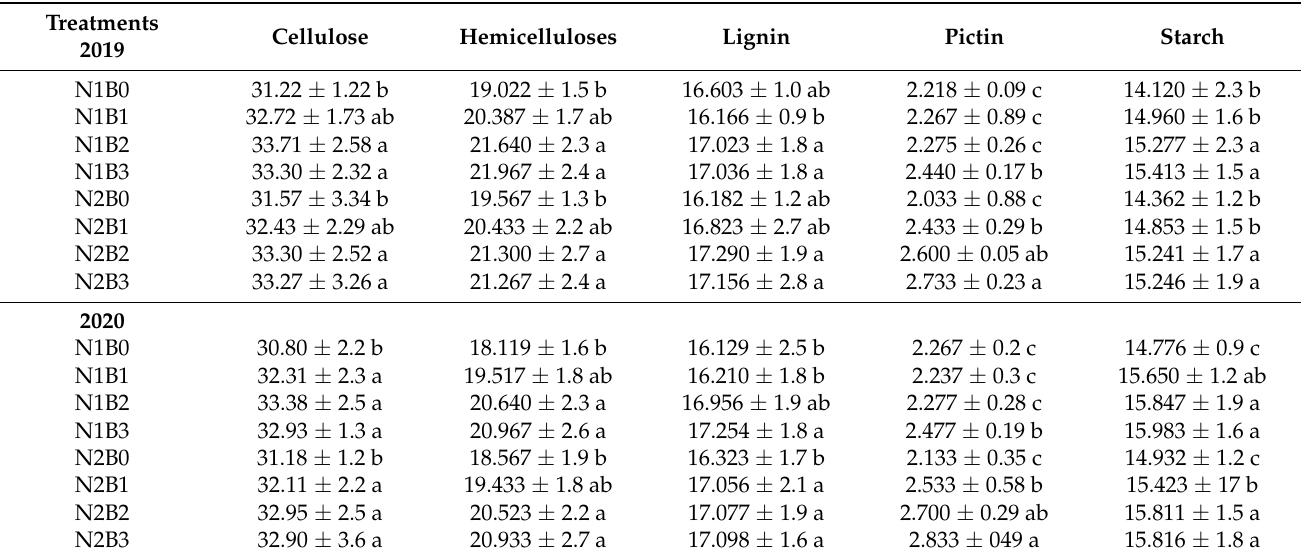
Table 1. Biomass compositions (% dry matter) in raw materials and SE residues of rice treated with biochar and nitrogen